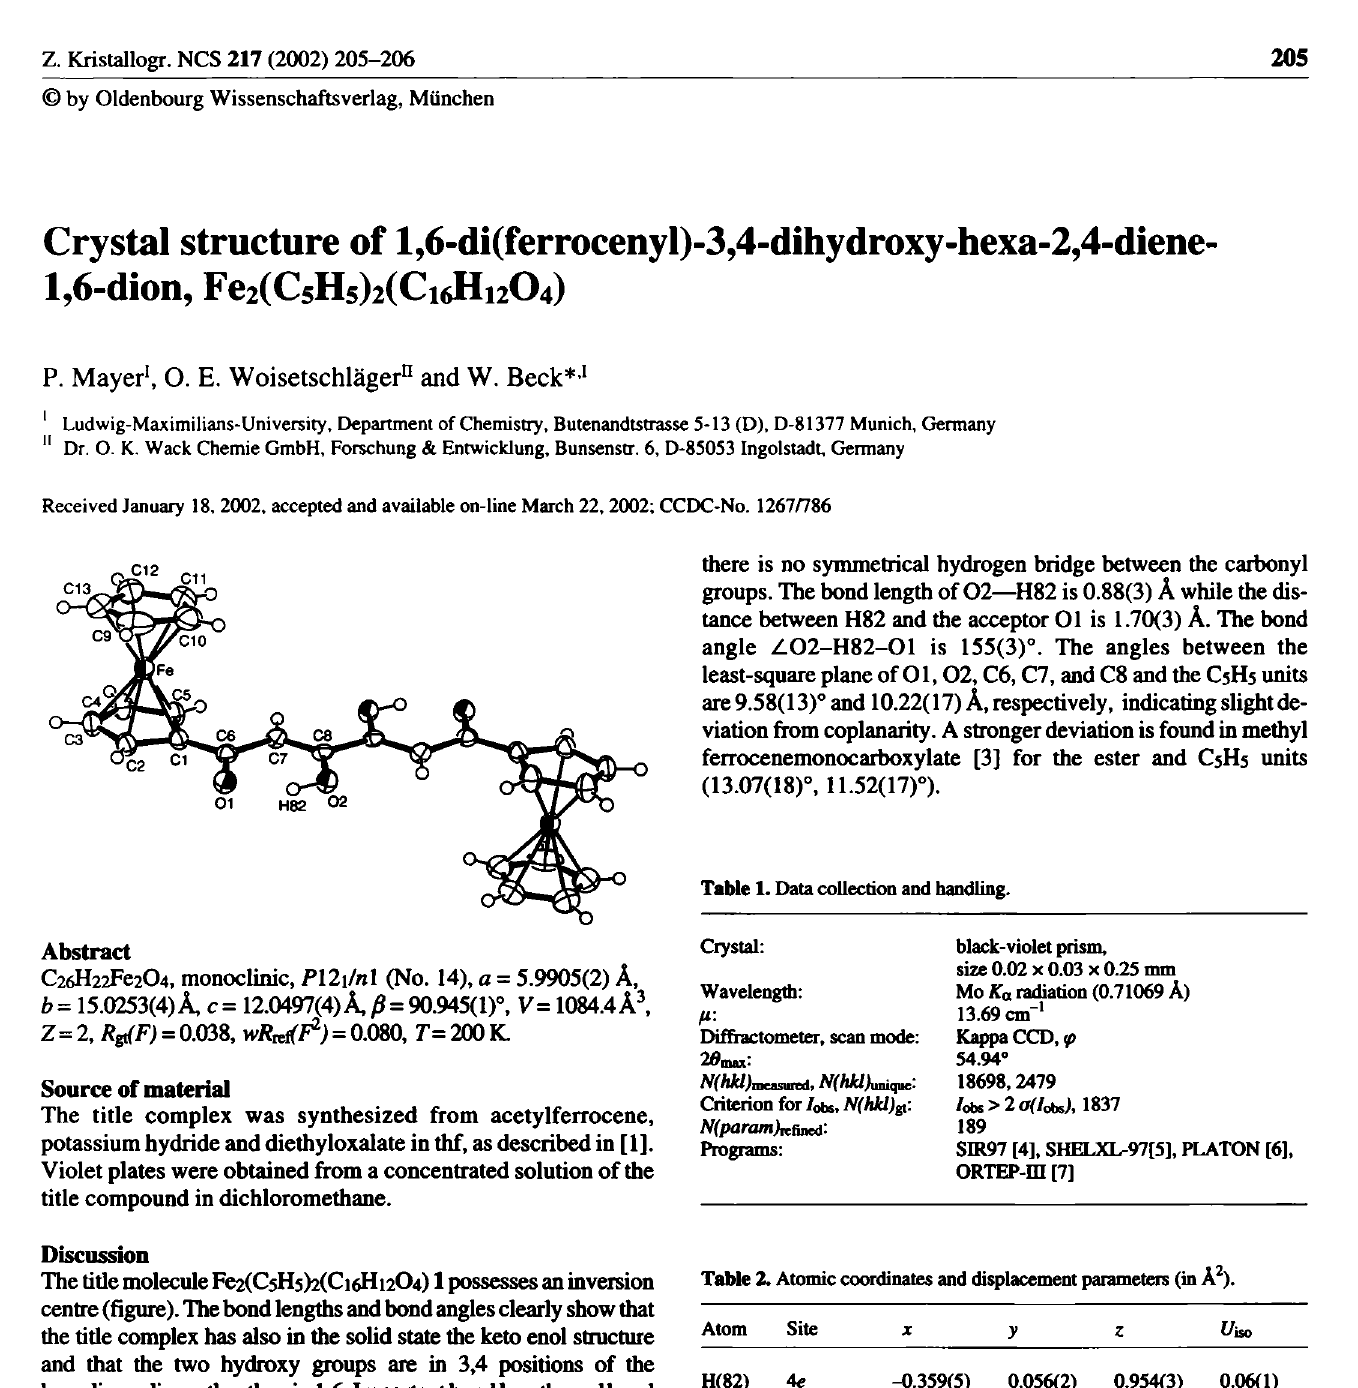
Table 2. Atomic coordinates and displacement parameters (in Â 2